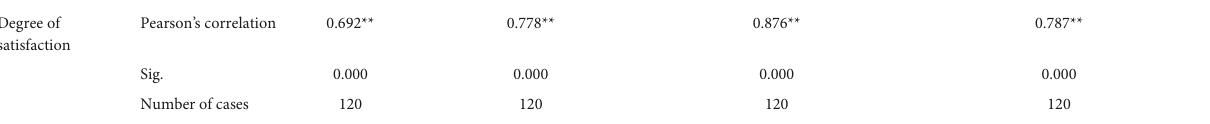
TABLE 3 Correlation analysis of learner satisfaction with suite quality, curriculum suitability, improvement in individual students’ abilities, and human–computer interaction. Kit quality Curriculum suitability Individual improvement Human–computer interaction